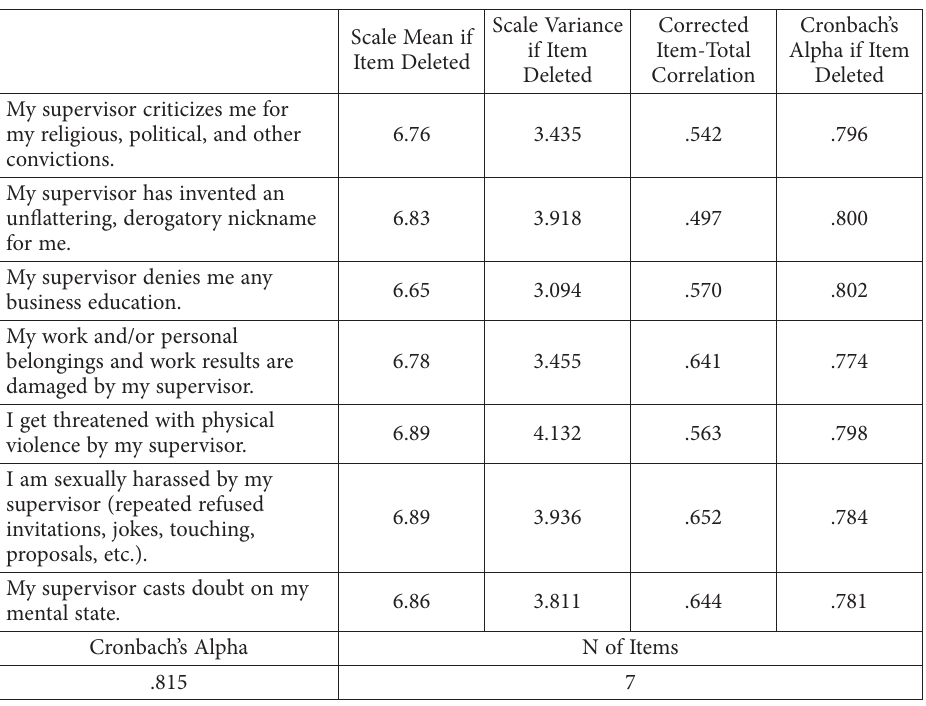
Table 3. Psyche-Aimed Bossing internal consistency